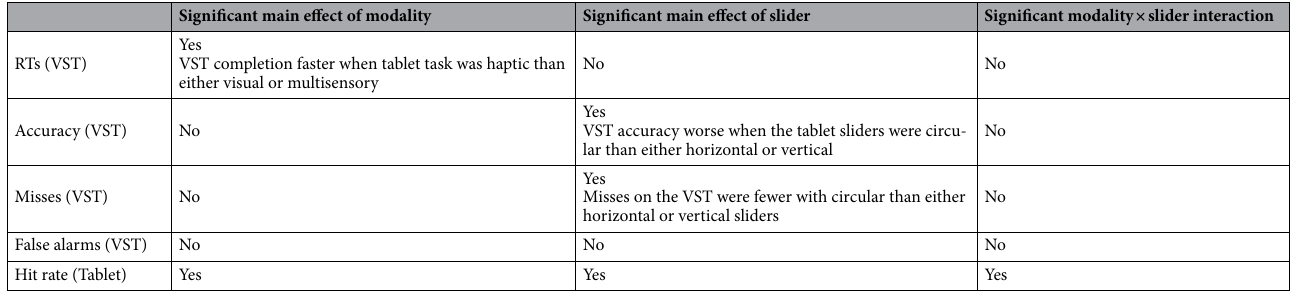
Table 1. Summary of results of 3 × 3 rmANOVAs and post-hoc tests.